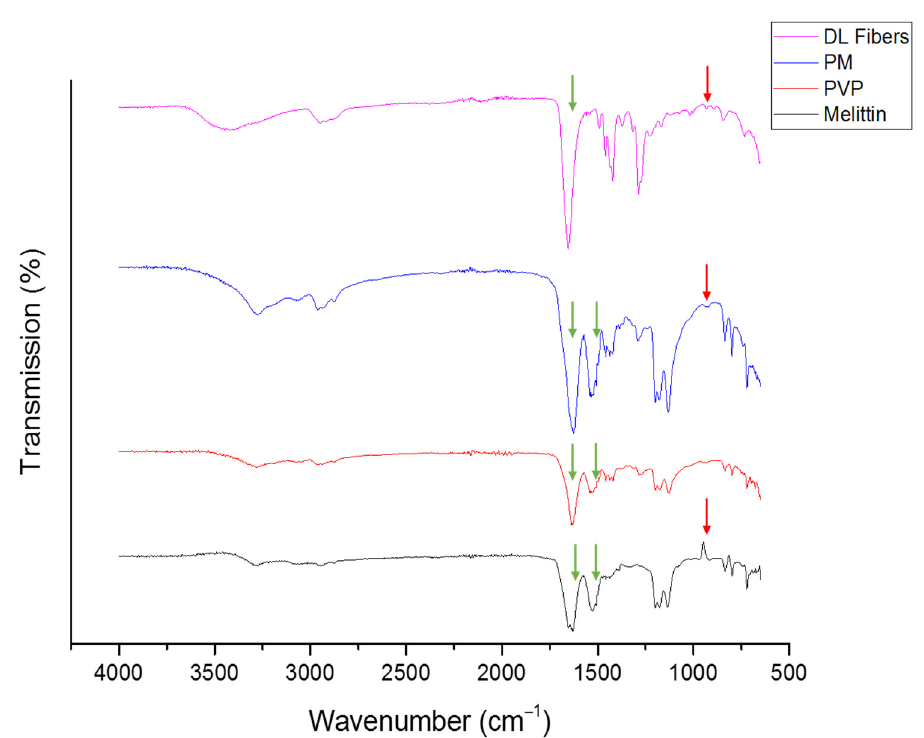
Figure 3. FTIR transmissions of PVP, melittin, PM and melittin fibers showing the characteristic peaks merge at 1500 cm − 1 and 1620 cm − 1 in the fibrous system but not in the PM (green arrows), which indicates the intermolecular formation bonds between melittin and PVP. A distinctive peak of melittin at 948 cm − 1 which appeared in the PM and drug-loaded fibers and not in the PVP transmission suggests melittin presence in the fibrous system (red arrows). PM: physical mixture, DL: drug-loaded.